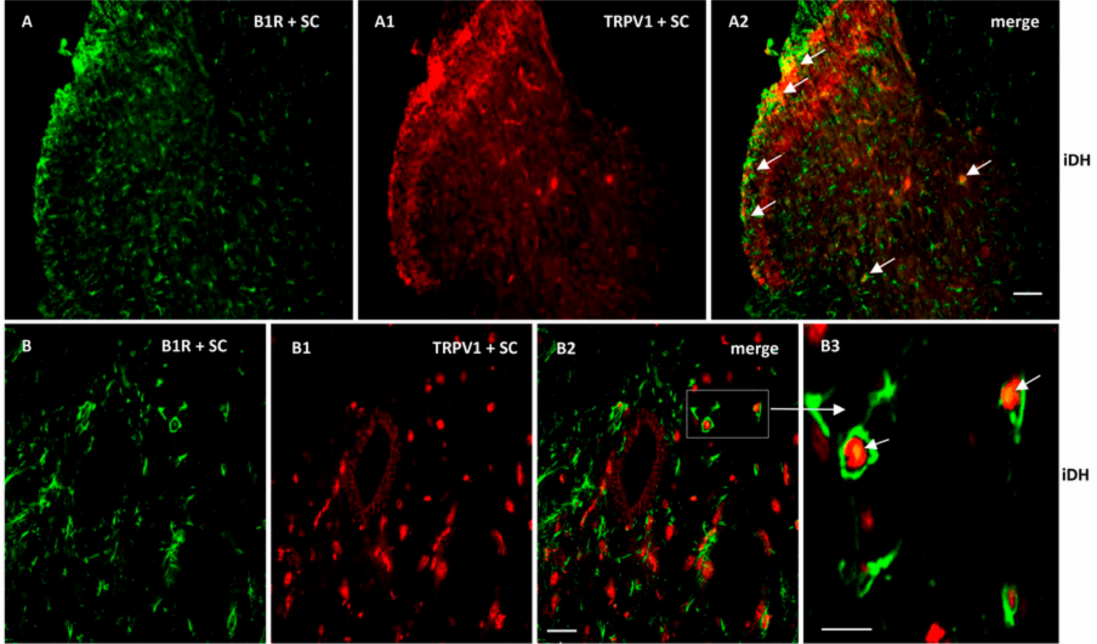
Figure 7. Co-expression of B1R and TRPV1 in the ipsilateral Dorsal Horn (iDH). Representative microphotographs by immunofluorescence of B1R (green, A , B ) and TRPV1 (red, A1 , B1 ) in the spinal cord (SC) of PSNL rats. Images A2 , B2 and B3 reveal a co-expression of B1R and TRPV1 (white arrows) at superficial layers of the dorsal spinal cord. Scale bar = 120 µ m ( A – A2 , 10 × ), 60 µ m ( B – B2 , 20 × ) and 50 µ m ( B3 , 40 ×